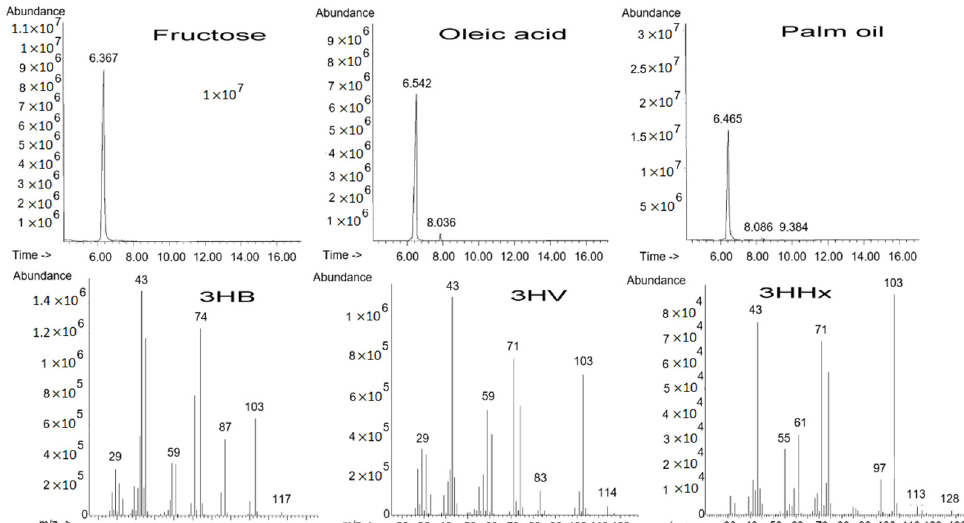
Figure 3. Ion chromatograms with mass spectra of methyl esters of the monomers constituting PHAs synthesized by Cupriavidus necator IBP/SFU-1 from different carbon sources with retention times: methyl-3-hydroxybutyrate (3HB)—6.367–6.542; methyl-3-hydroxyvalerate (3HV)—8.036–8.086; methyl-3-hydroxyhexanoate—9.384 min. 1.1 × 10. Table 1. Composition and properties of PHAs synthesized by Cupriavidus necator IBP/SFU-1 from various carbon sources. No. Carbon